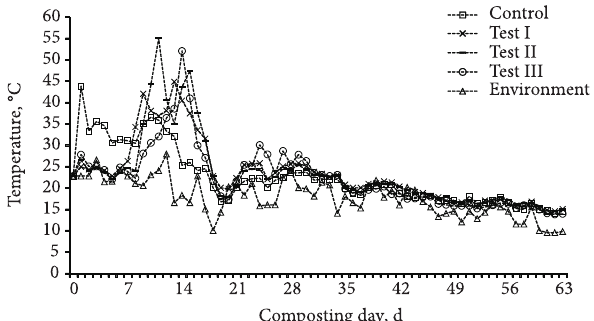
Fig. 1. The temperature profile during composting